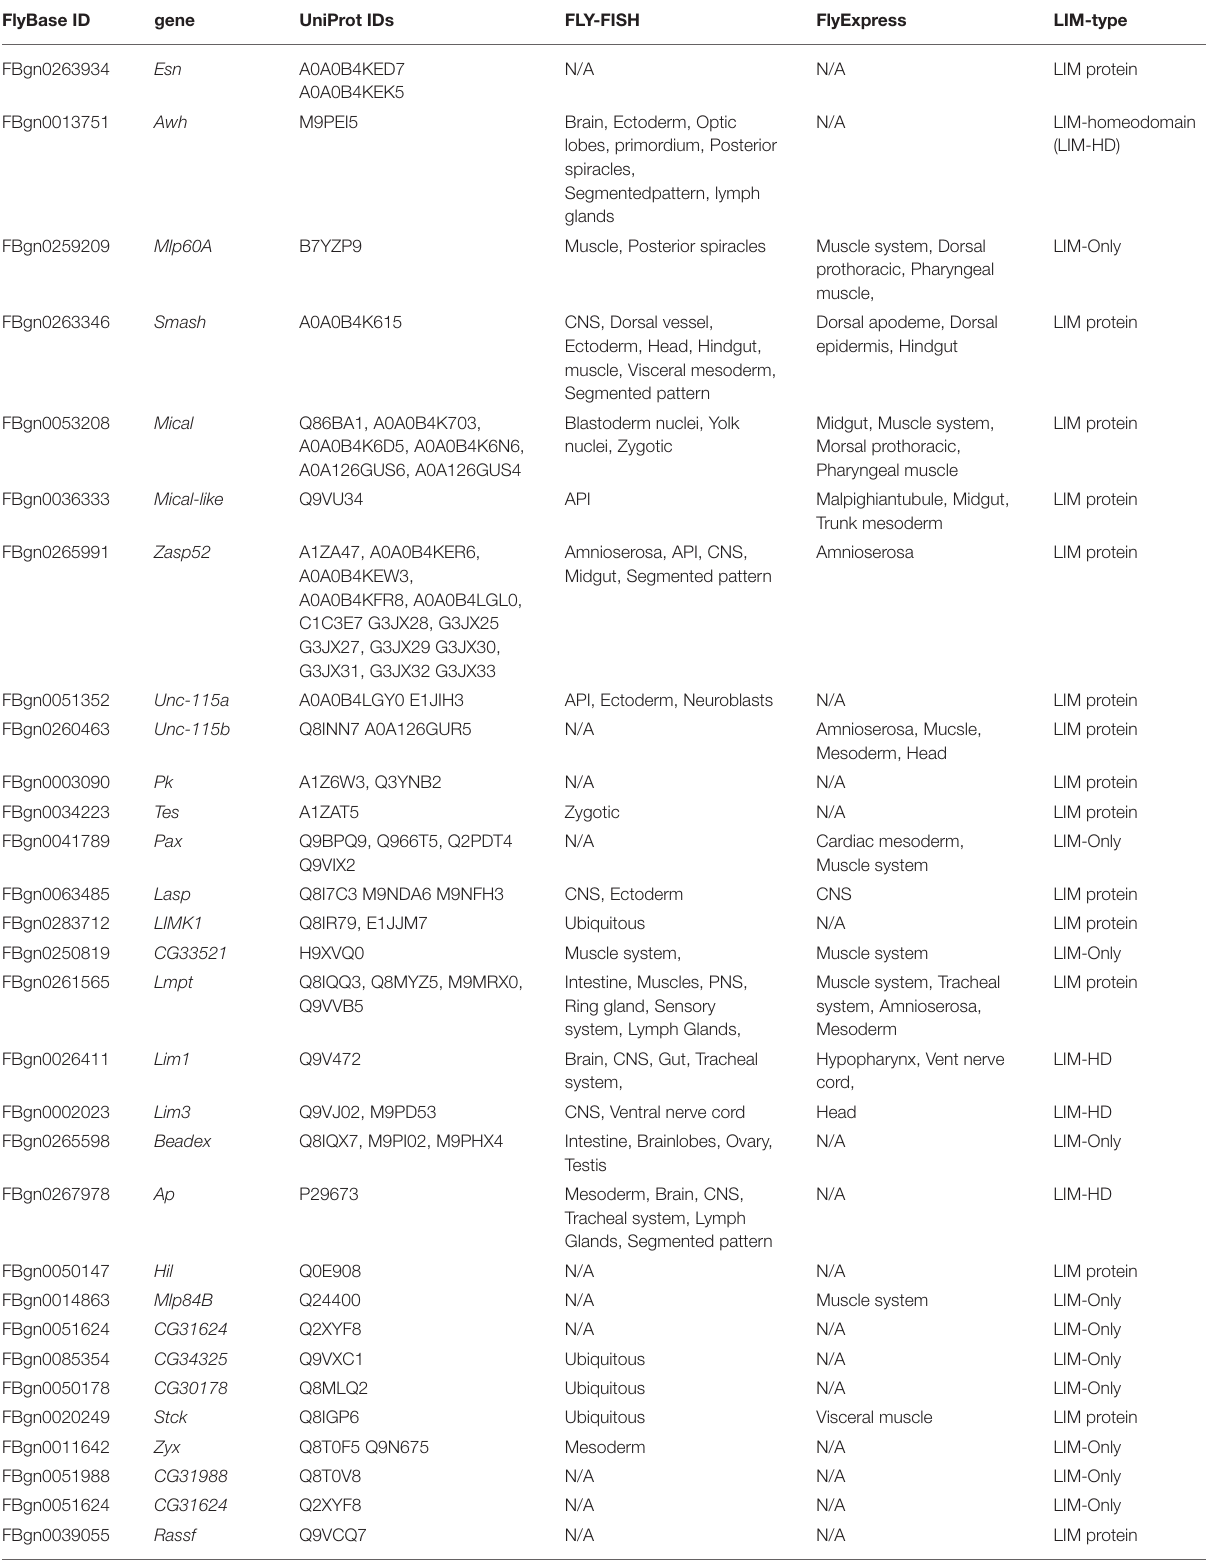
TABLE 1 | List of the various transcripts and proteins with LIM domain in Drosophila melanogaster . FlyBase